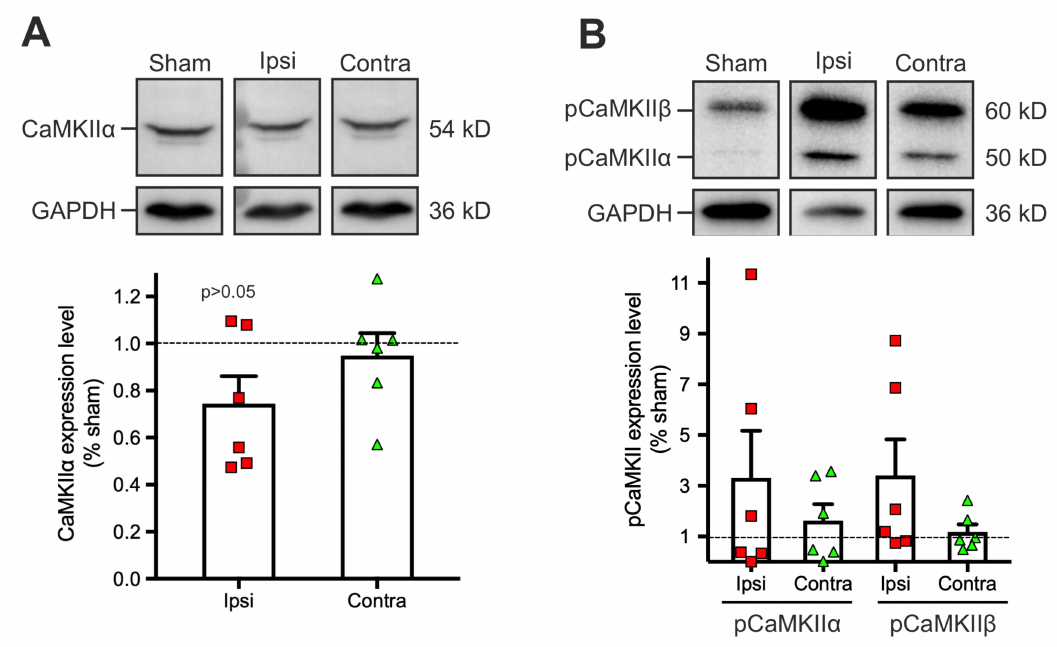
Figure 3. Phosphorylation levels of calcium-calmodulin dependent kinase II (CaMKII α ) in the acute period after TBI are not significantly altered. Exemplary Western blots of CaMKII α ( A ) and phosphorylated CaMKII (pCaMKII) ( B ). In the lower section, protein levels from brain lysates of the respective cortical areas of interest are depicted in scatter plots for CaMKII α ( n = 6 from 6 mice for each experimental condition) and pCaMKII ( n = 6 from 6 mice for each experimental conditions). Expression levels were quantified after normalization to the housekeeping protein GAPDH. The dashed line represents the CaMKII α protein level in sham-operated animals, normalized to 1, the data points in the scatter plots represent the relative values for protein expression levels in the ipsilateral or contralateral hemisphere per animal, bars and error bars represent mean and SEM. For statistical analysis pairwise Mann-Whitney-U test was performed, they revealed no significant di ff